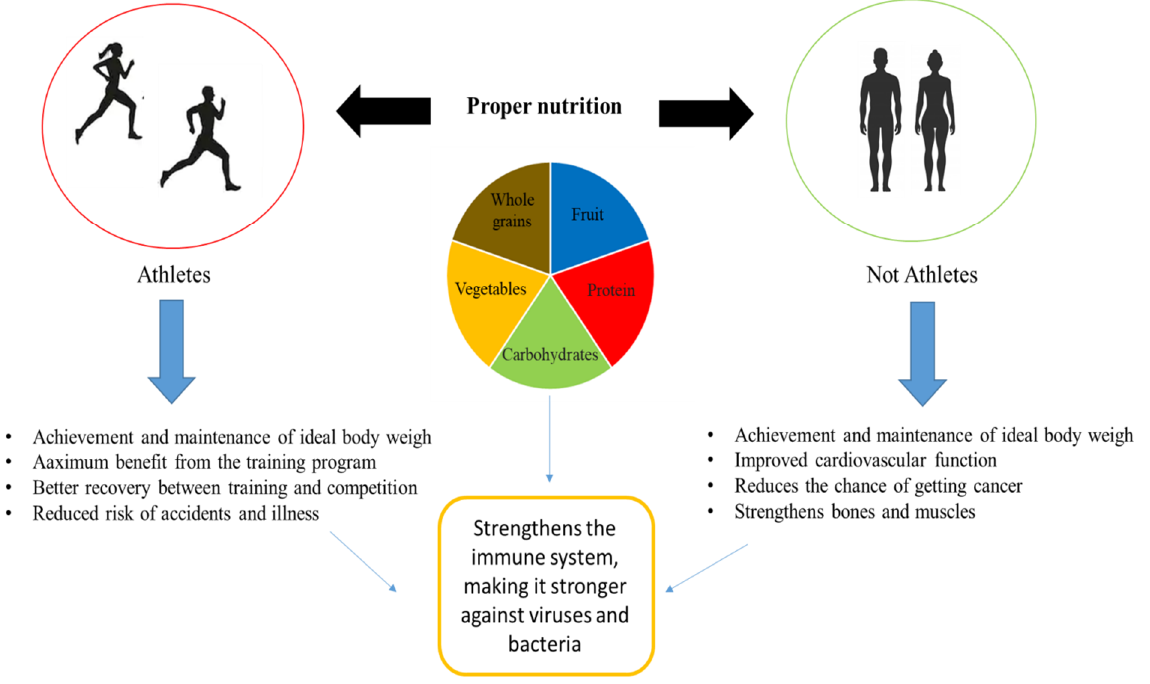
Figure 4. Proper nutrition.